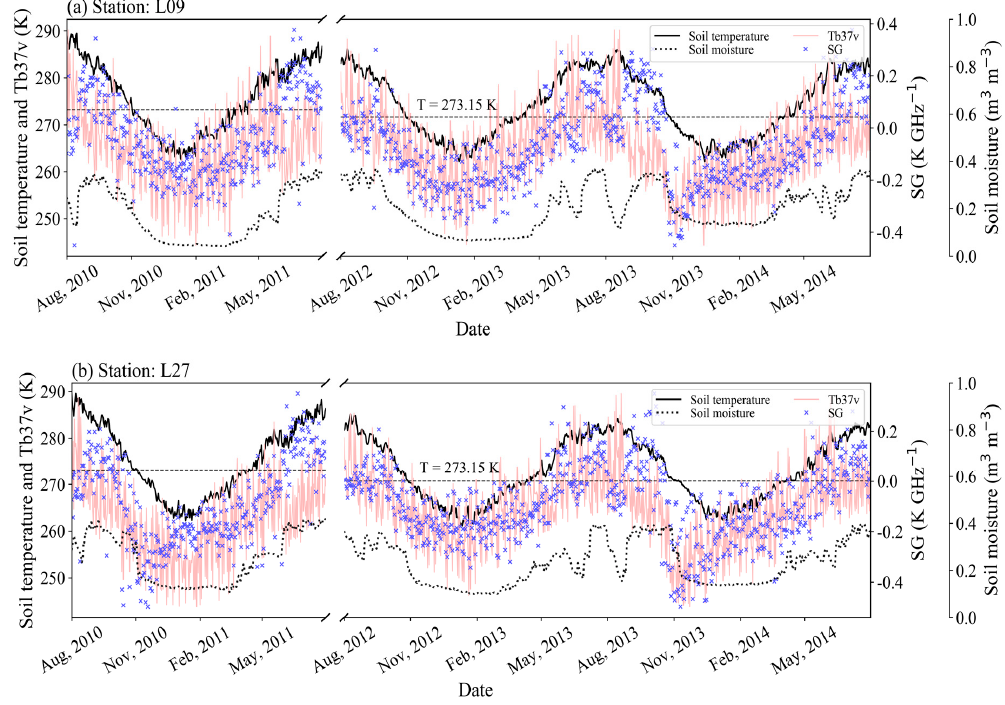
Figure 3. Time series of Tb37v and ground-based measurements of soil temperature and moisture at Station L9 ( a ) and Station L27 ( b ) over the study periods.